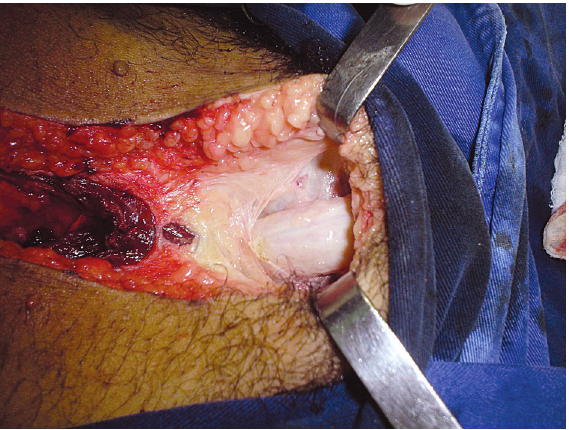
Figure 1 – Dissection of the corpora cavernosa to the point of attachment with the crus penis.